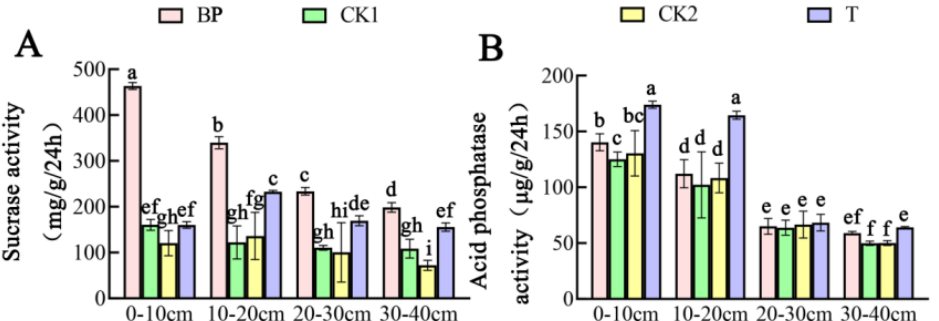
Figure 7. Trends of enzyme activities at different soil layers under different rice mulching